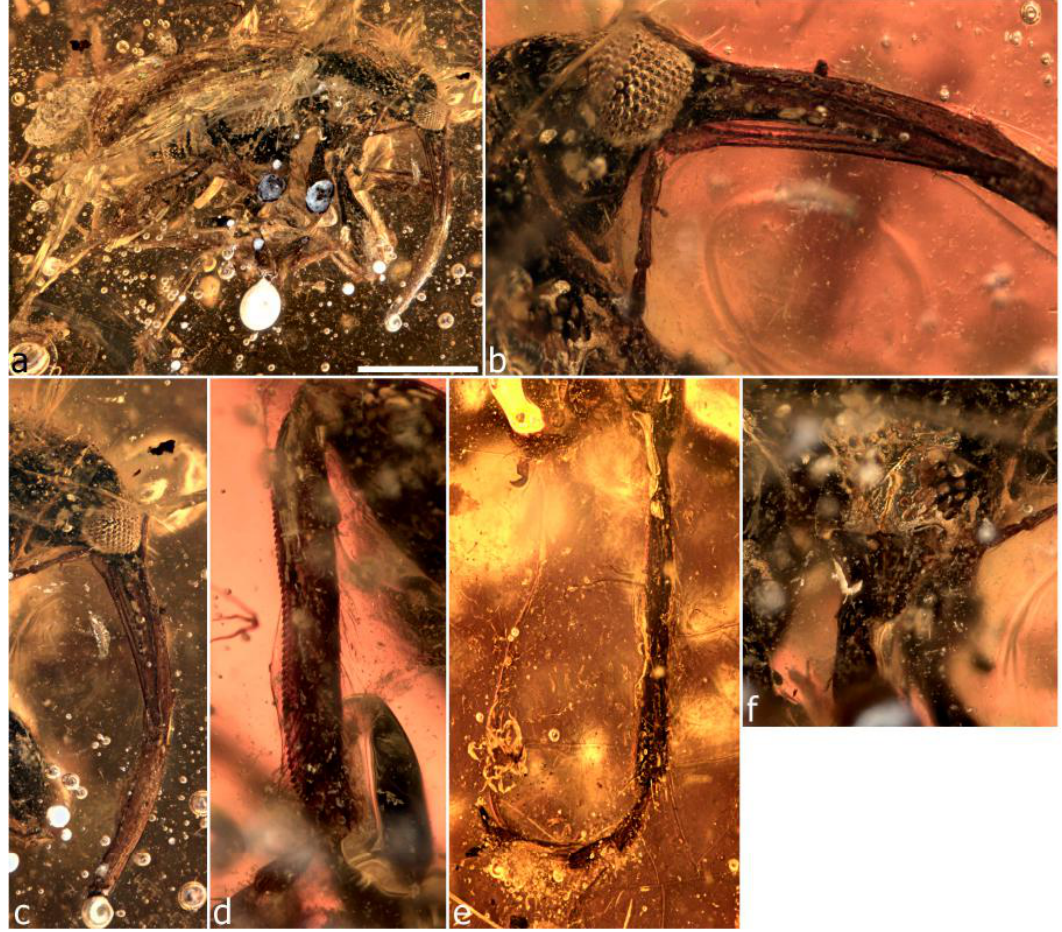
Figure 63. Mekorhamphus poinari sp. n., holotype. Habitus, right lateral ( a ); detail of head, right lateral ( b ); head, right lateral ( c ); right metatibia ( d ); left mesotibia and -tarsus, dorsal ( e ); prothorax showing notosternal suture, right lateral ( f ). Scale bar: 1.0 mm (a).